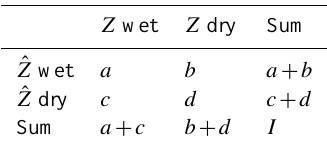
Table 1. 2 × 2 contigency table for the calculation of HK from observation-prediction pairs { Z i , ˆ Z i }